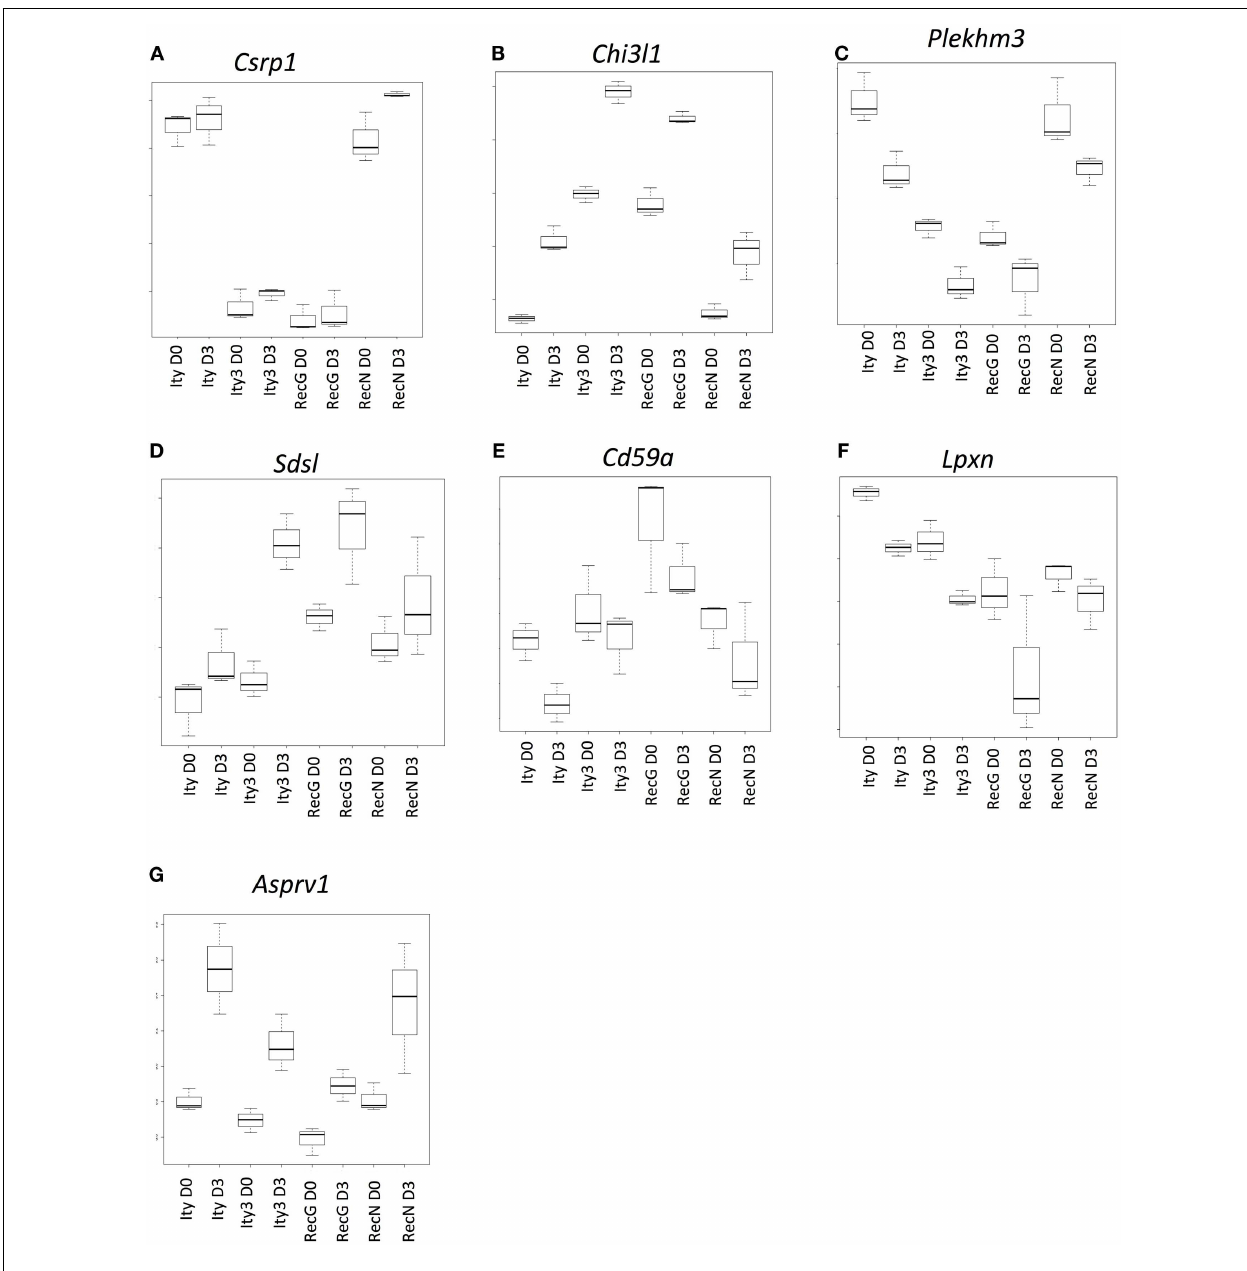
Supplementary Material, which show similar expression patterns in Ity3 and Ity3.RecG , but different from Ity and Ity3.RecN .These genes are likely under the control of the Ity3.1 locus. Csrp1 (cysteine and glycine-rich protein 1), Chi3l1 (chitinase-like 1), ( Plekhm3 ) Pleckstrin homology domain containing, family M, member 3), Sdsl (serine dehydratase-like), Cd59a (CD59a antigen), Lpxn (leupaxin), Asprv1 (aspartic peptidase, retroviral-like